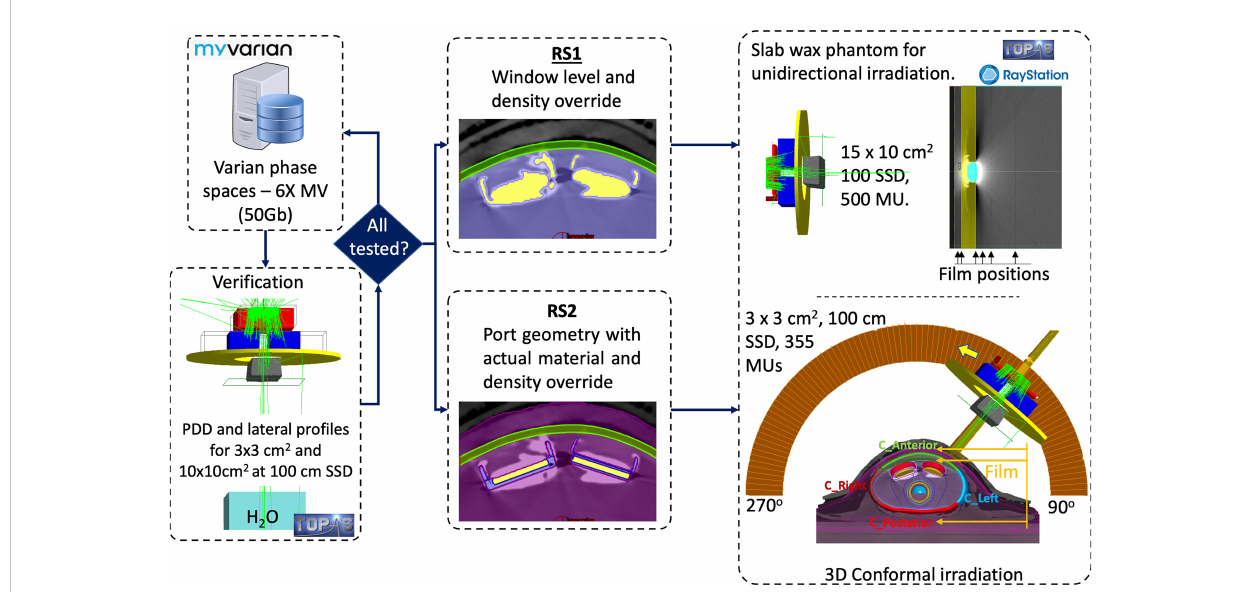
FIGURE 2 Simulation work fl ow. Phase space fi les were obtained from myVarian webpage and veri fi ed with Monte Carlo simulations of two open fi elds. Subsequently, two strategies were used to identify or override the metal artifact using RayStation TPS. Finally, both strategies were studied and compared with fi lm measurements. Two irradiation setups were considered, the fi rst using an AP beam and a slab wax phantom stacked between plastic water; the second using conformal beam irradiating the TTE fi lled with water embedded in a customized wax